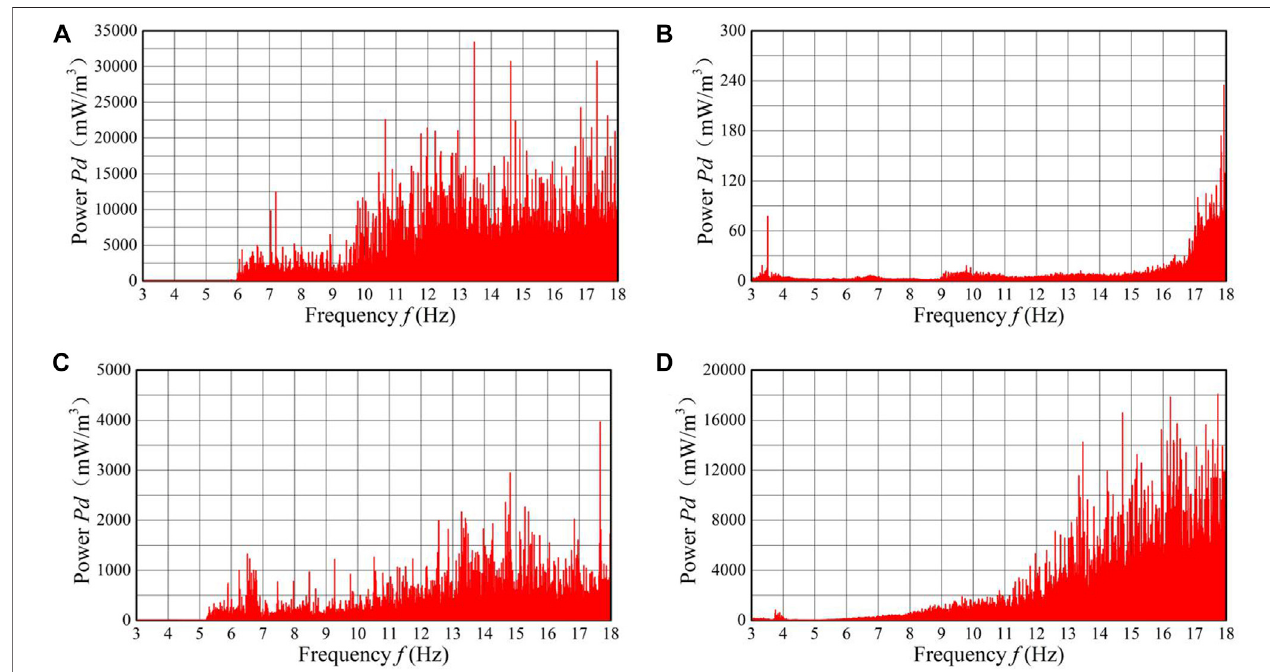
FIGURE7| Powerdensityofthefrequency-sweeptestunder13 mmpeak-to-peakexcitationat3 – 18 Hzsweepfrequency. (A) PowerdensityofLM-FTGintheVV mode. (B) Power density of LM-FTG in the VH mode. (C) Power density of LM-FTG in the HV mode. (D) Power density of LM-FTG in the HH mode.